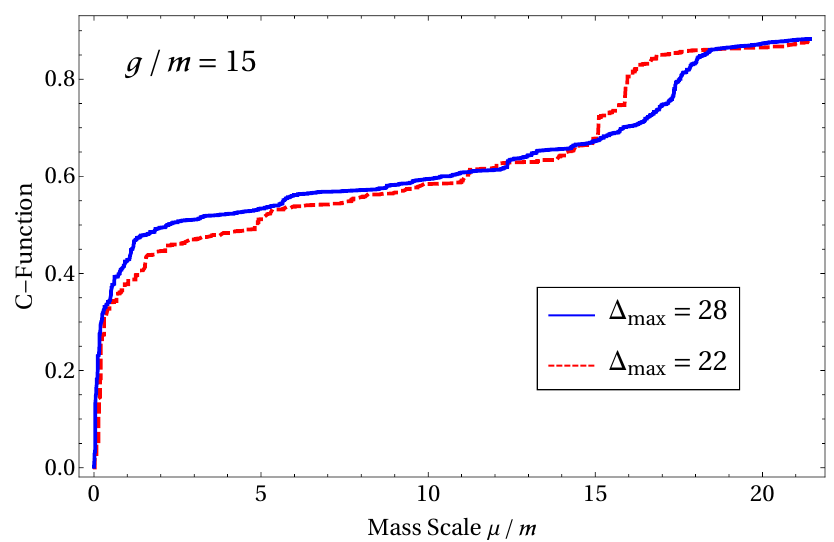
Figure 10 . The C -function of the SUSY broken phase at g = 15. The coupling is chosen to be far beyond the critical point, g (cid:29) g , where g ≈ 1 . 5, so that the TIM critical behavior is not present. ∗ ∗ At this coupling, the spacing between individual mass eigenvalues is smaller than the resolution of this plot, so the plot shows continuous curves. The blue solid curve is the numerical C -function at the largest truncation level ∆ max = 28. The red dashed curve is computed at a lower truncation level ∆ max = 22. The difference between the two curves qualitatively reflects the convergence of the C -function at different mass scales µ . At very large and very small µ , the result is still sensitive to truncation. At intermediate µ , the function stabilizes between 0 . 4 < C ( µ ) < 0 . 6, in agreement with the Ising model central charge c Ising = 0 . 5. The leading deviation from the Ising prediction is due to the higher-dimensional deformation TT , which can lift the asymptotic value of the C -function above c Ising as ∆ max → ∞